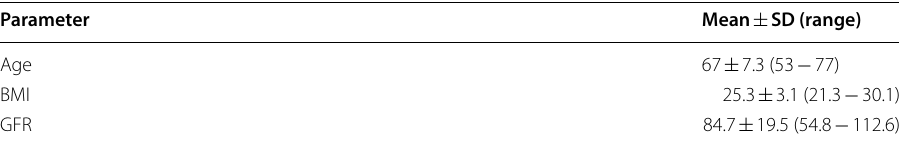
Table 1 Patient